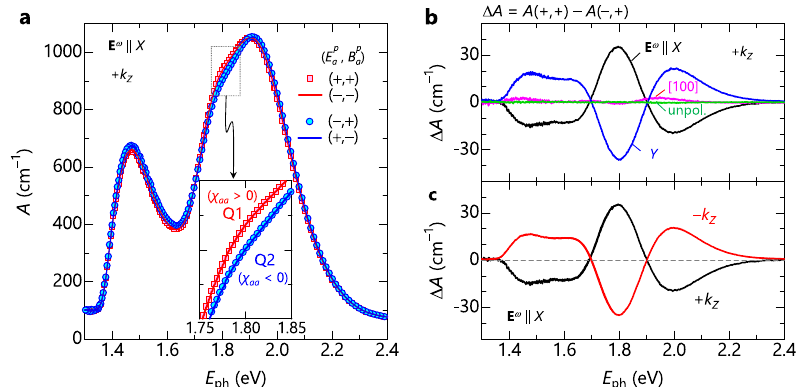
Fig. 4 Evidence for nonreciprocal linear dichroism. a Absorption coef fi cient ( A ) spectra at 4.2 K for X -polarized light propagating along the + Z direction, after cooling with four different sign combinations of poling fi elds ( E p a , B p a ). The poling fi elds are removed before each measurement. The inset of a displays the magni fi ed view in the 1.75 – 1.85 eV region. b Subtracted absorption spectra Δ A = A ( + , + ) − A ( − , + ) for X -, Y -, [100]-polarized, and unpolarized light.